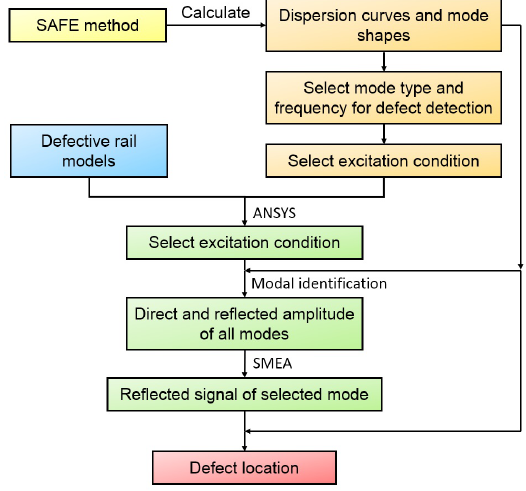
Figure 21. Flow chart describing the defect location algorithm described in Reference